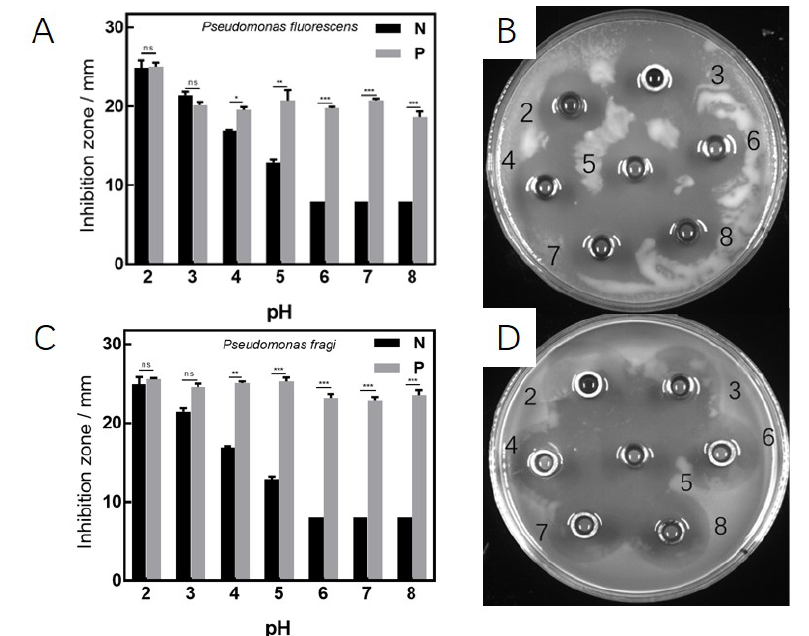
Figure 7. Antibacterial . effects under different pH of D. algida against the target Pseudomonas , where ( A , B ) are the diameter and appearance, respectively, of the produced inhibition zone of P. fluorescens , and ( C , D ) are the diameter and appearance, respectively, of the produced inhibition zone of P. fragi . The numbers in (B) and (D) stand for the pH. The data are shown as mean ± SD ( n = 3), * p < 0.05, ** p < 0.01, *** p <